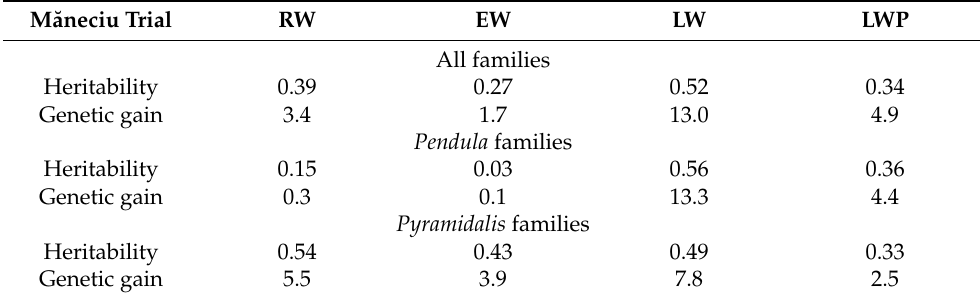
Table 4. Family heritability and genetic gain for 10% selection intensity.